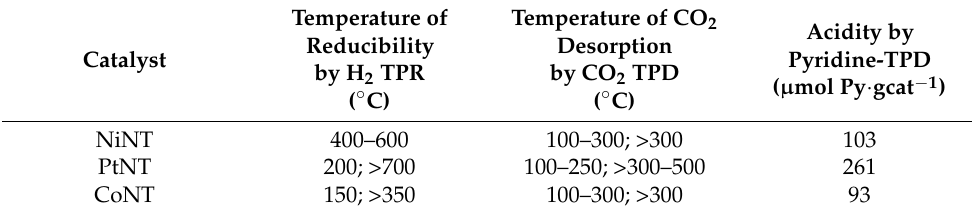
Table 4. General features of the solids investigated by TPR and acidity measurements of the CoNT, NiNT and PtNT fresh